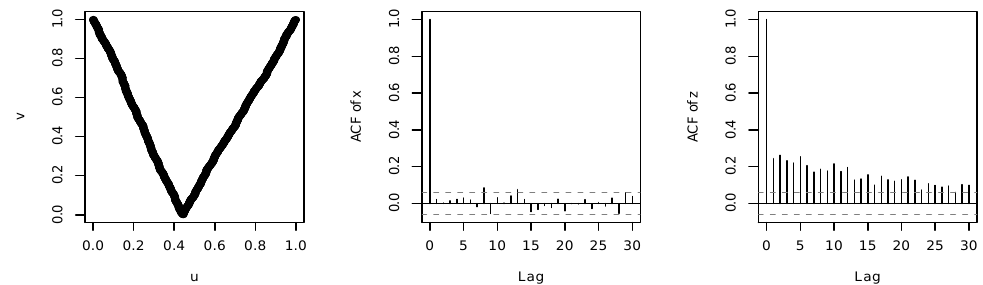
Figure 1. Scatterplot of v t against u t (left), sample acf of raw data x t (centre) and sample acf of z t = Φ − 1 ( v t ) (right). The transformed data are defined by v t = F distribution function of the x t and | x t | values, respectively. The sample size is n = 1043 and the data are daily log-returns of the Bitcoin price for the years